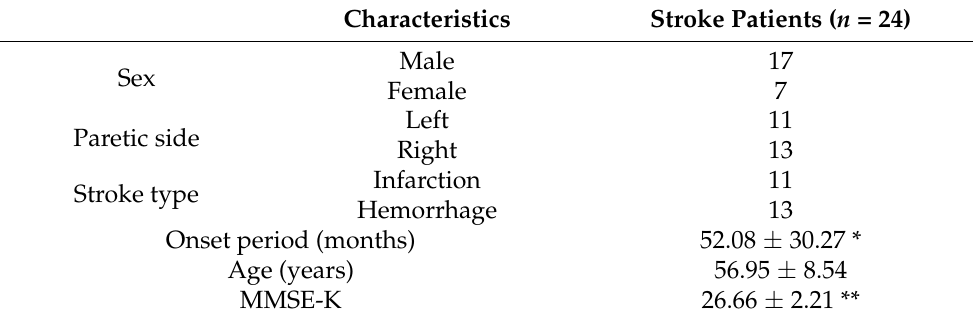
Table 1. Patient demographics.